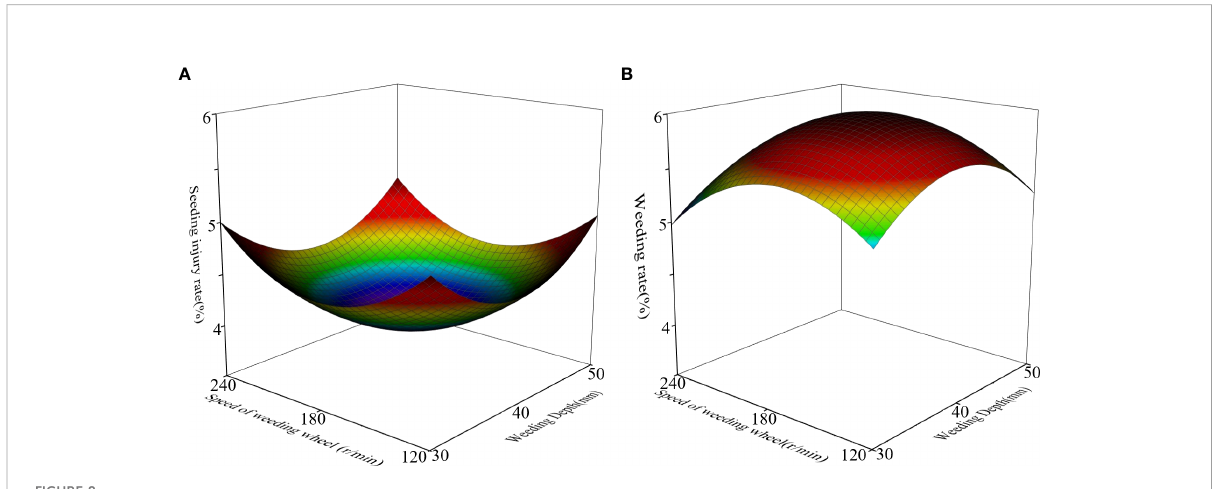
FIGURE 8 Response surfaces for (A) injury rate and (B) weeding